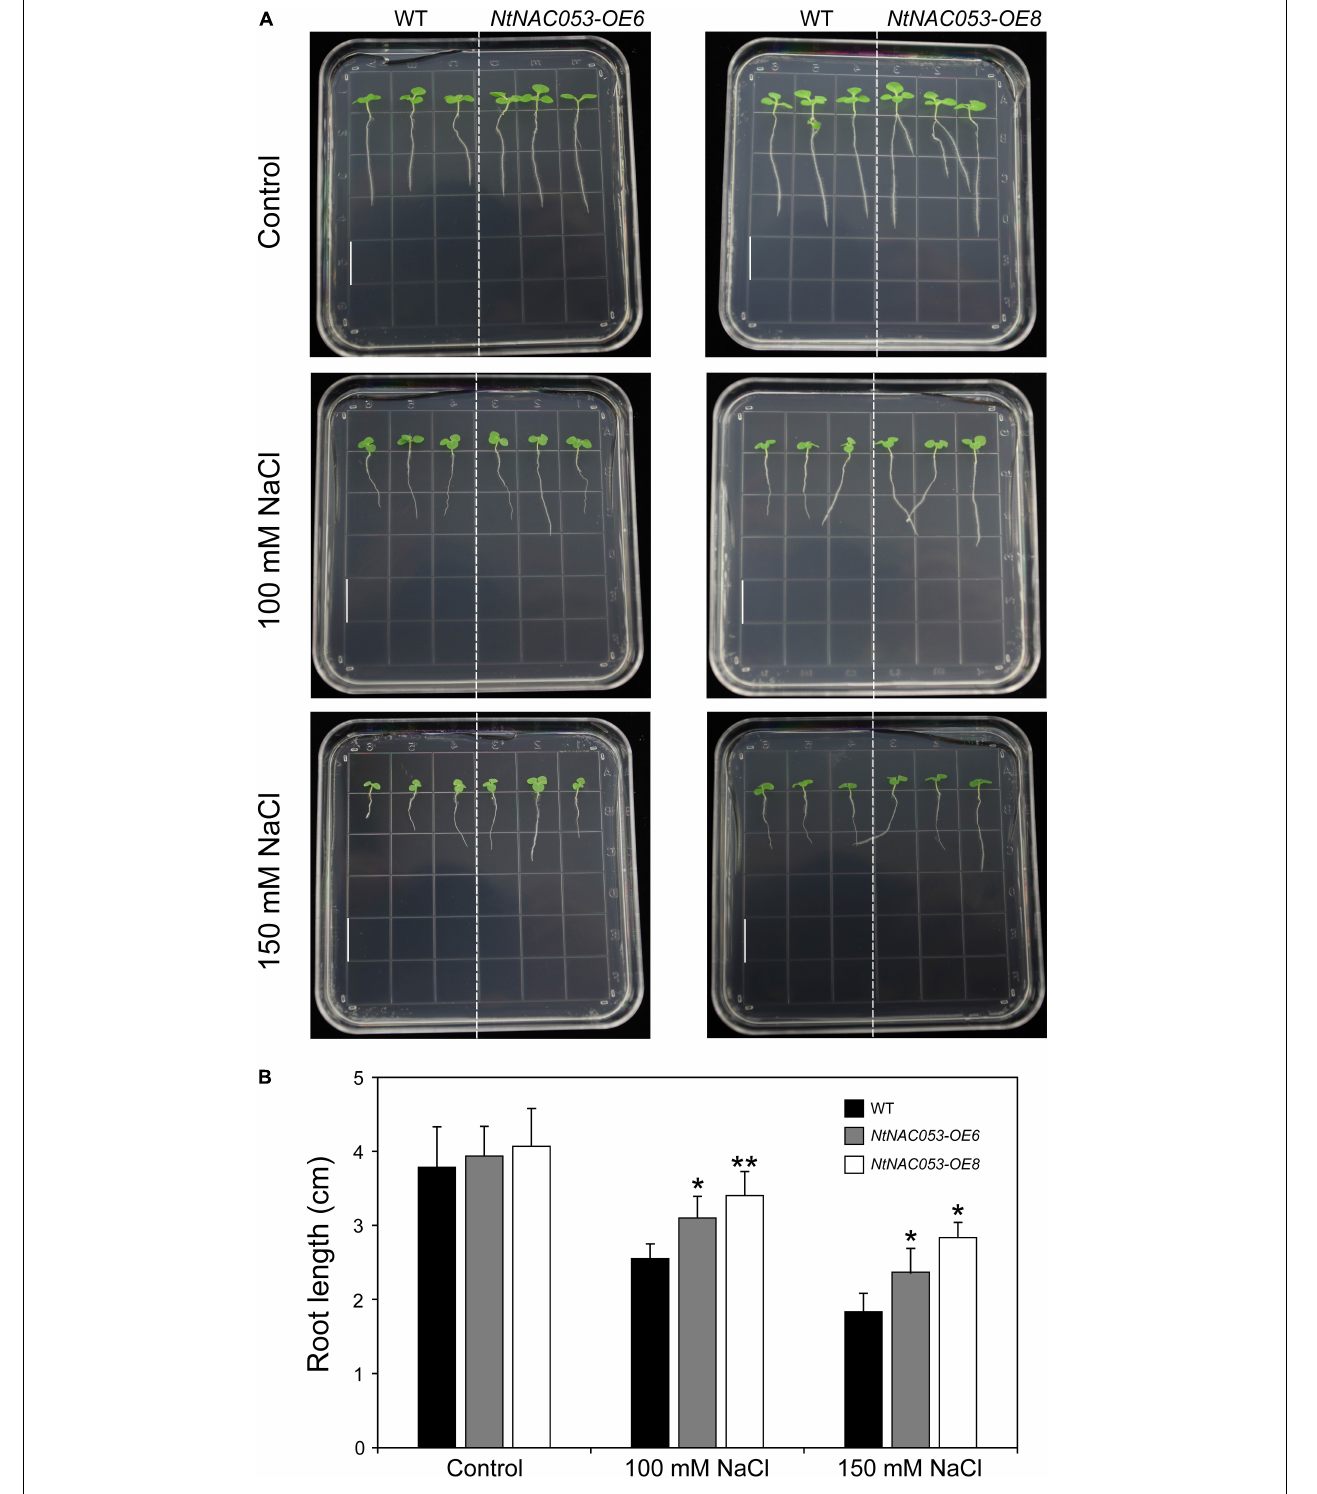
FIGURE 6 | Comparison of root growth between overexpression lines and wild-type tobacco under salt stress treatments. (A) The primary root length of overexpression lines and wild-type tobacco under 100 mM and 150 mM NaCl treatments. The primary root length was recorded 7 days after growth. Bar = 1.5 cm. (B) The statistics of primary root length under normal conditions and NaCl treatments. WT, wild type. The data were means ± SD from three independent replications. * p < 0.05, ** p < 0.01 ( t -tests).